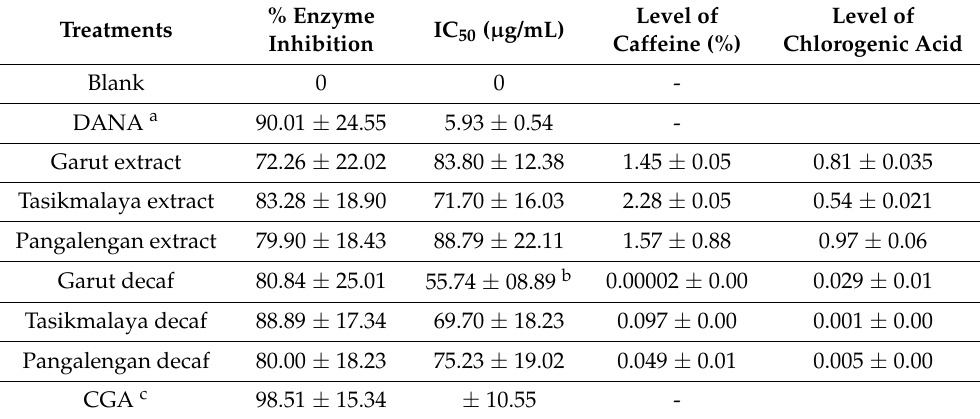
Table 4. The NA inhibition activities of non-decaf and decaf coffee from different regions in West Java. Level of Level of % Enzyme IC 50 ( µ g/mL) Treatments Caffeine (%) Chlorogenic Acid Inhibition Blank DANA a